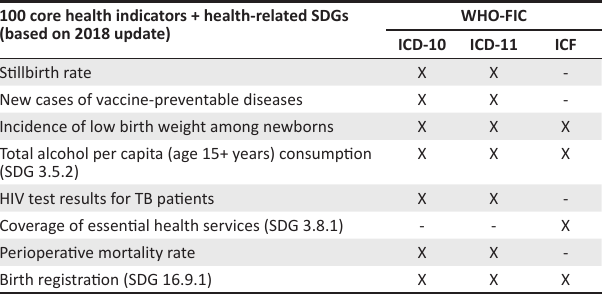
TABLE 1: Tracking of universal health coverage indicators using the International Classification of Functioning, Disability and Health. 100 core health indicators + health-related SDGs (based on 2018 update)